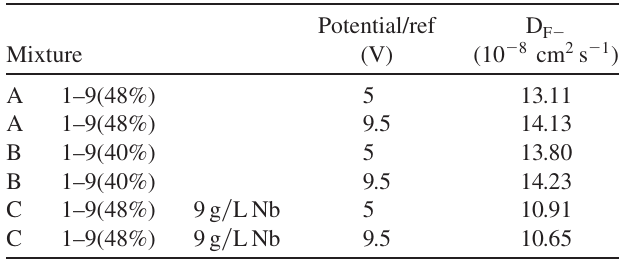
TABLE II. Values calculated for the diffusion coefficient D at 5 and 9.5 V.